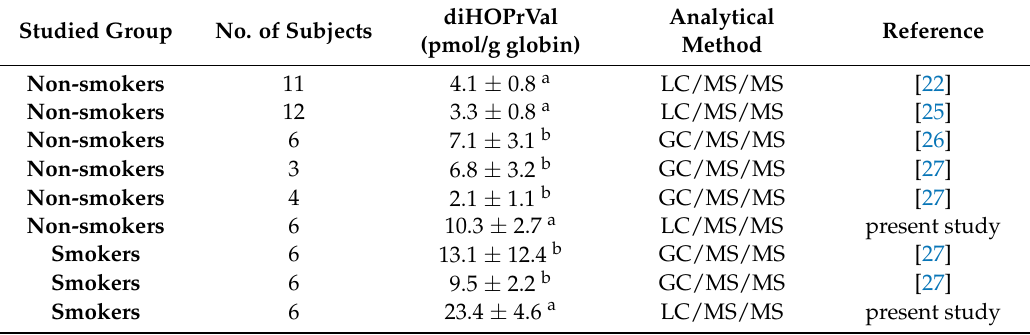
Table 2. Steady state levels of the Hb adduct N -(2,3-dihydroxypropyl)valine (diHOPrVal) in adult subjects (from different countries) without any known exposure, obtained in published studies.